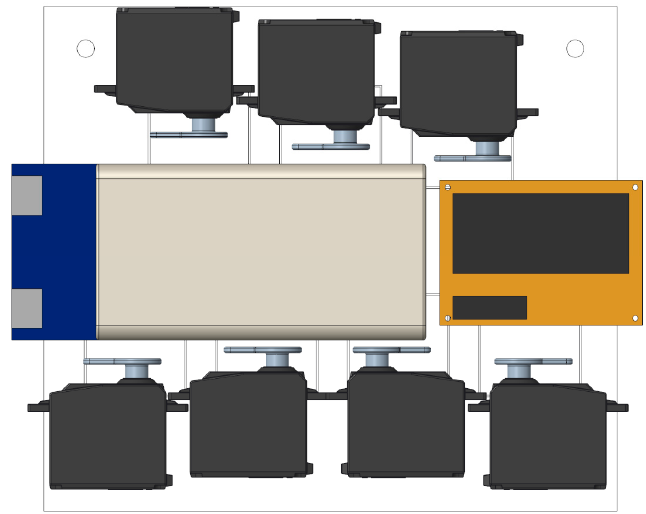
Figure 4. Distribution of the servomotors, battery, and control module.